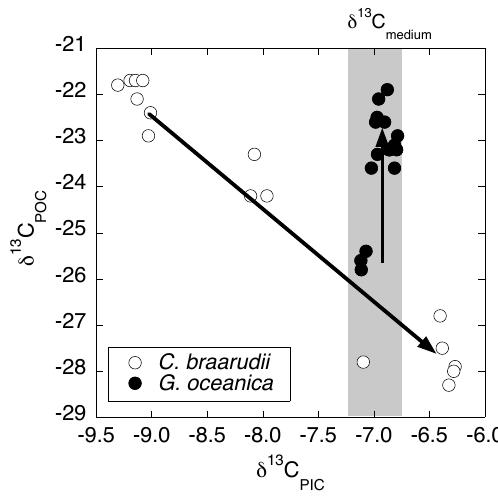
Figure 6 Fig. 6. A simple plot of δ 13 C org versus δ 13 C cocco for G. ocean- ica (black circles) and C. braarudii (open circles) with the arrows pointing towards the conditions of increasing DIC etc during each experiments. The contrasting physiologies of the two species under these manipulations become immediately apparent. The grey box highlights the range at the beginning and end of the culture experi-